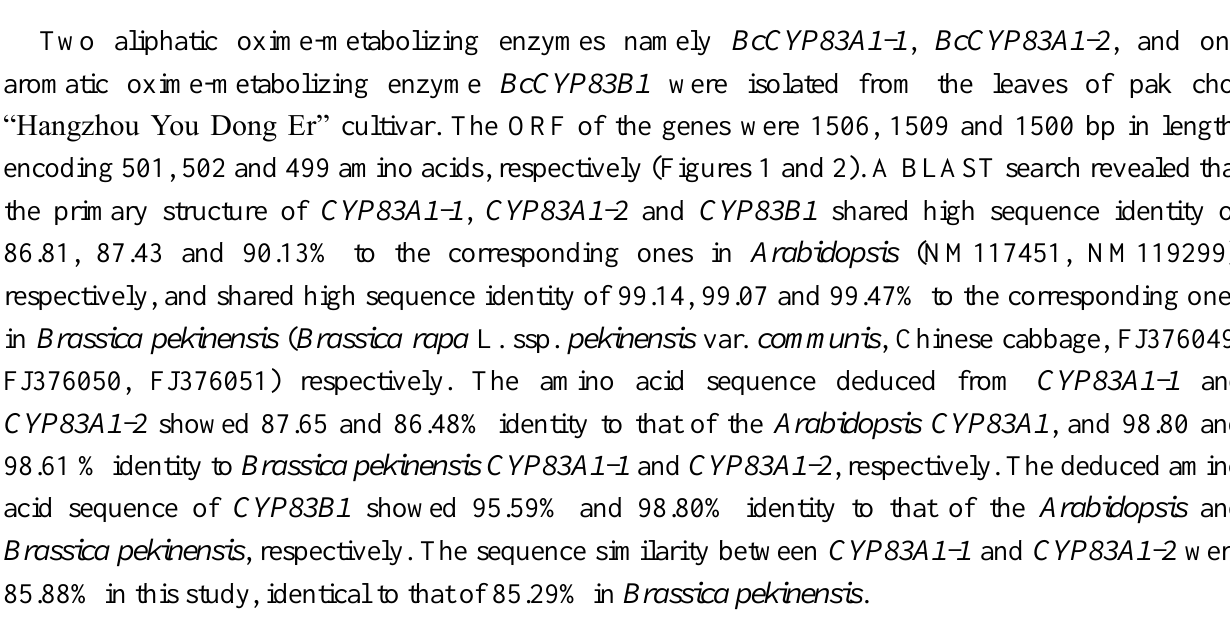
Figure 1. Multiple alignment of deduced amino acid sequences of CYP83A1 . Black shaded and other shaded boxes show identical and similar amino acids, respectively.